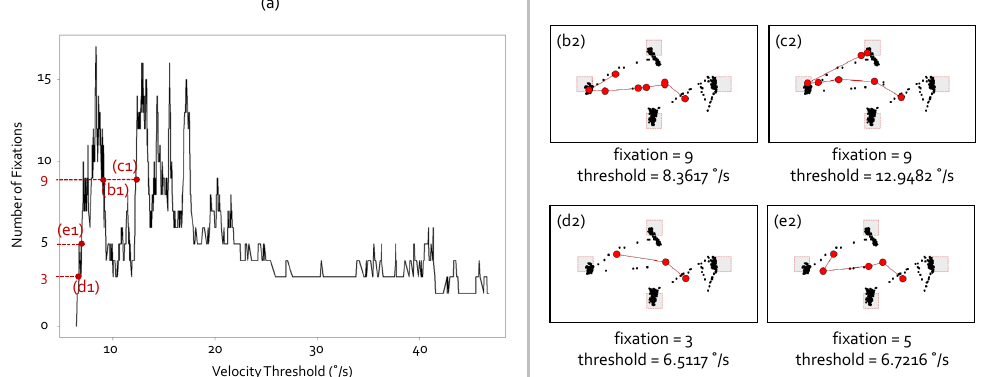
Figure 3. I-VT fixation identification. ( a ) shows the number of fixations according to the velocity threshold. The visualizations of ( b2 ), ( c2 ), ( d2 ), and ( e2 ) include the raw gaze points and scanpaths at ( b1 ), ( c1 ), ( d1 ), and ( e1 ) in ( a ), respectively. ( b2 ) to ( e2 ) show four cases of fixation identifications. The black dots denote the raw gaze points, and the red dots indicate the fixations. The red links are the